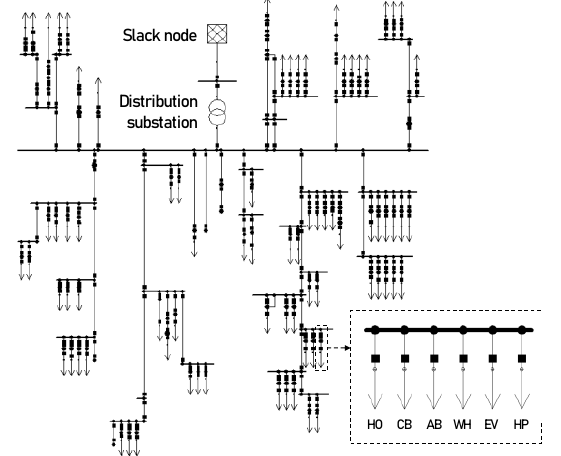
Figure 1. Grid model of an urban low-voltage grid located in the city outskirts.